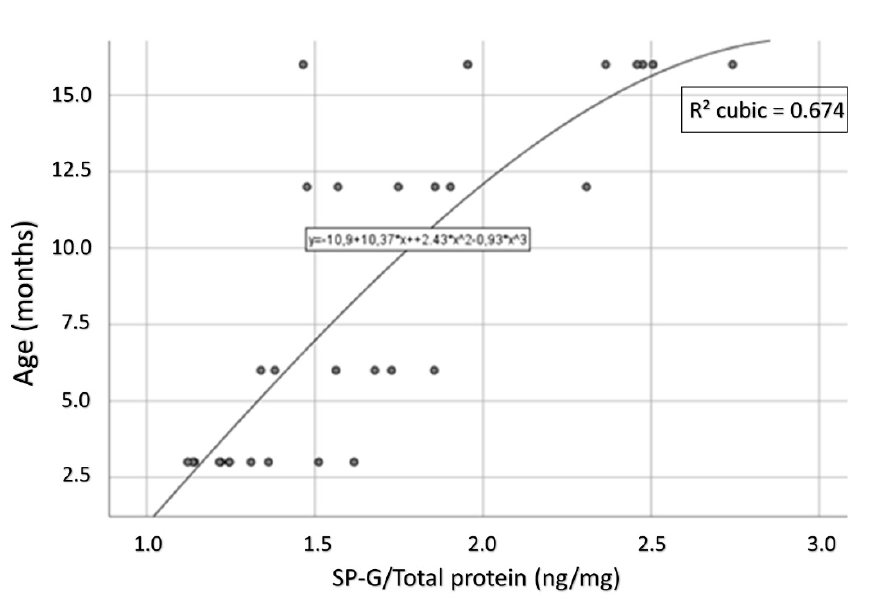
could be observed between the different age groups ( p = 0.847 and p = 0.164).